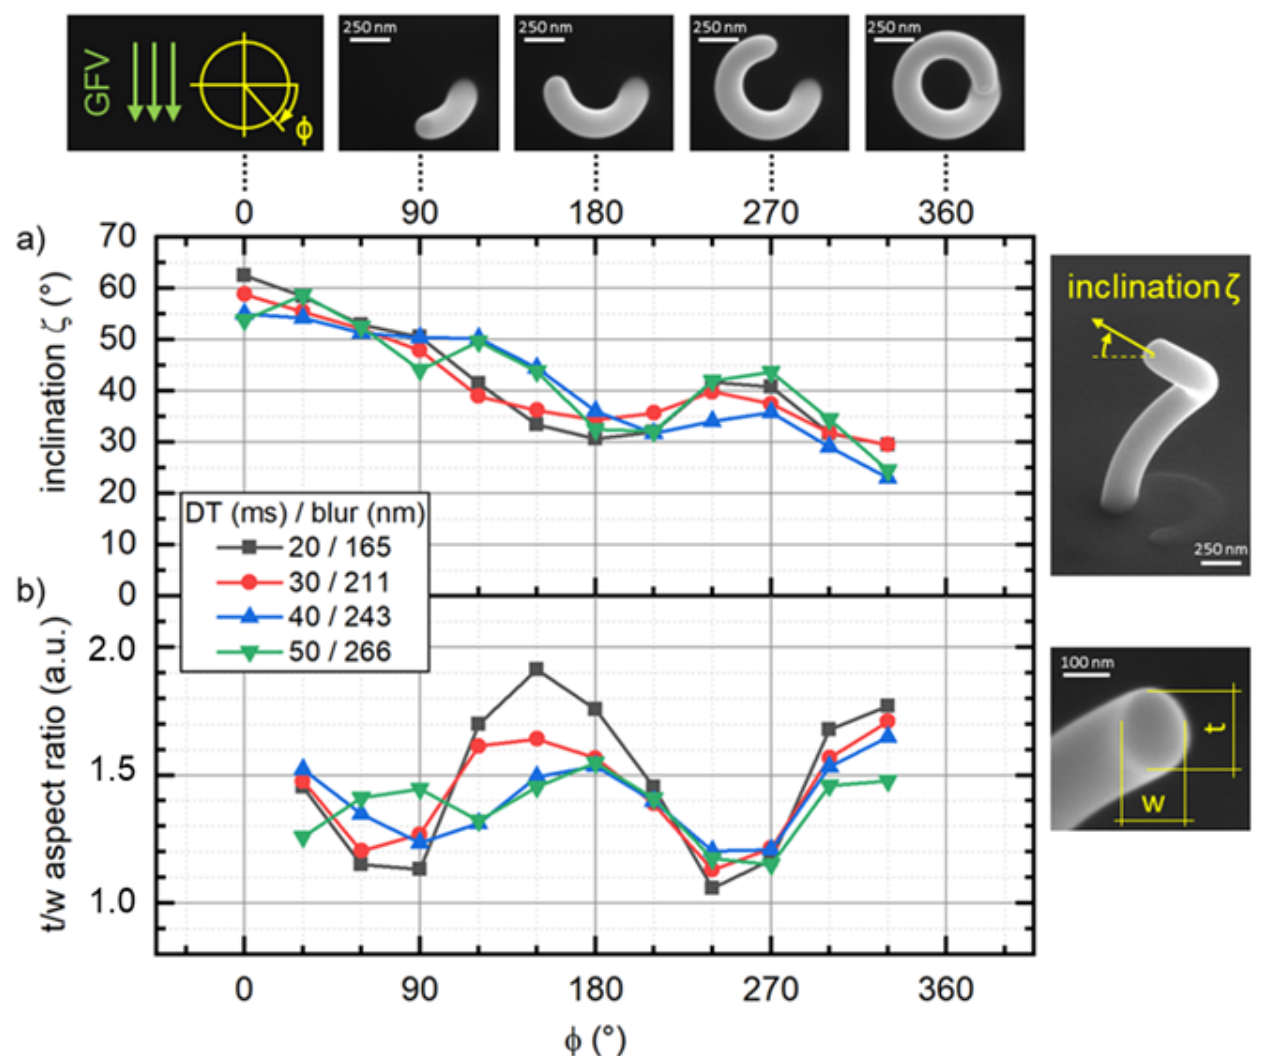
Figure 5. The evolution of inclination angles ( a ) and aspect-ratios ( b ) along the growth of 500 nm wide single turn helices, specified by the azimuthal angle φ . The top row shows SEM top view images to illustrate the successive clockwise growth of a helix together with the direction of the gas flux vector (GFV). Right column indicates the inclination angle ζ , the widths 𝑤 and the thicknesses 𝑡 . Both azimuthally resolved information are given for different blur values, where DT are adapted (see legend) to achieve a target inclination angle of 45°.